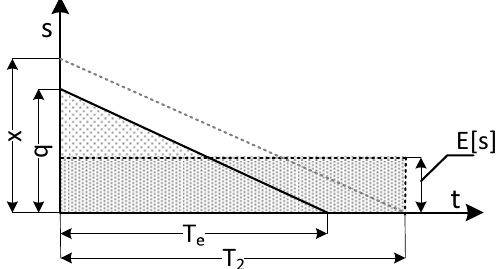
Fig. 2. Average stock when demand in T